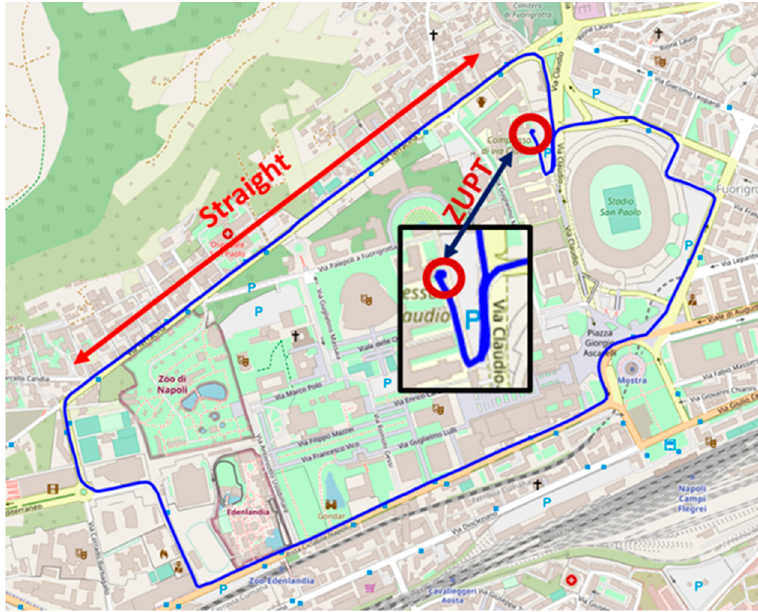
Figure 11. Nominal car route travelled in tests for position and attitude estimation.